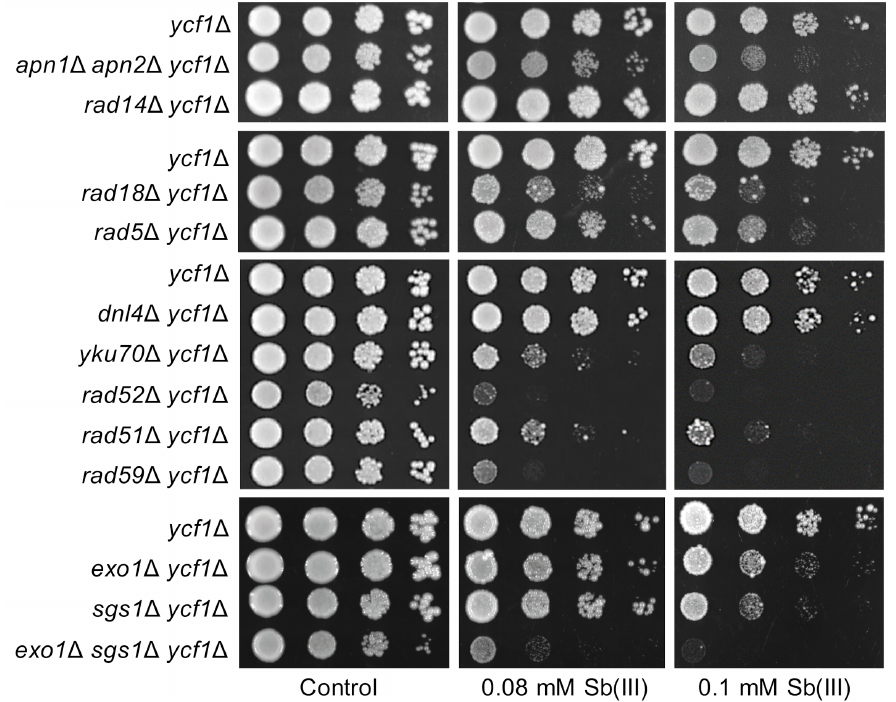
Figure 1. Role of DNA repair pathways in Sb(III) tolerance. Cultures of indicated mutants were serially diluted and plated on rich media in the presence or absence of Sb(III). Plates were incubated at 30 ◦ C for 2 days and then